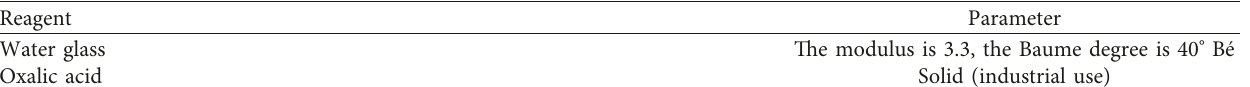
Table 2: Reagents used in the experiment.